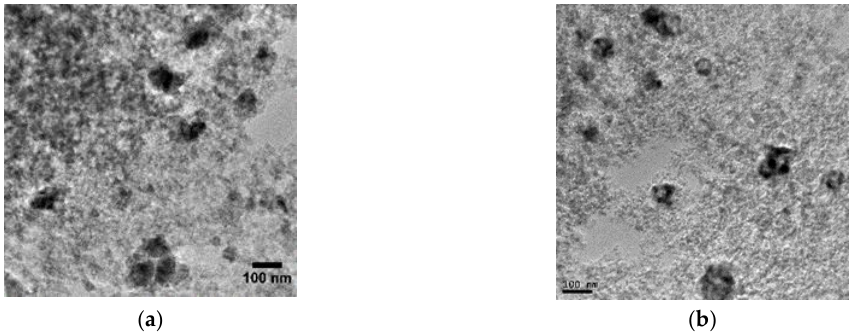
Figure 8. TEM images recorded for Co/SiO 2 catalyst before ( a ) and after reaction ( b ) under continuous